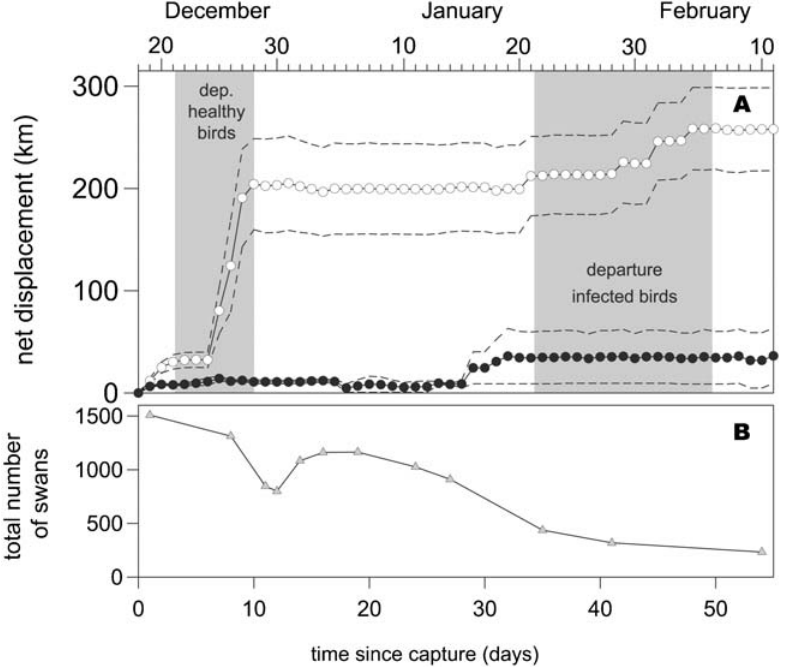
Figure 3. Timing of migration in healthy and infected swans. ( A ) Infected swans left the study area more than a month after the uninfected birds, indicated by broad vertical grey bars ranging from mean-SE to mean + SE. Moreover, their mean net displacement after departure (closed dots 6 dashed SE-lines) was shorter than for the uninfected birds (open dots 6 dashed SE-lines). Sample sizes of displacements estimates: n =2 for infected birds (whole time span); sample size declined for uninfected birds due to birds that flew out of range: n =10 (days 0–41), n =9 (42–47), and n =8 (48–55). ( B ) Total number of swans in our study area declined more or less gradually over time (W. Tijsen et al. unpubl. data), suggesting a continuous departure of about 30 birds per day (apart from the short dip around day 12 during a snowy cold